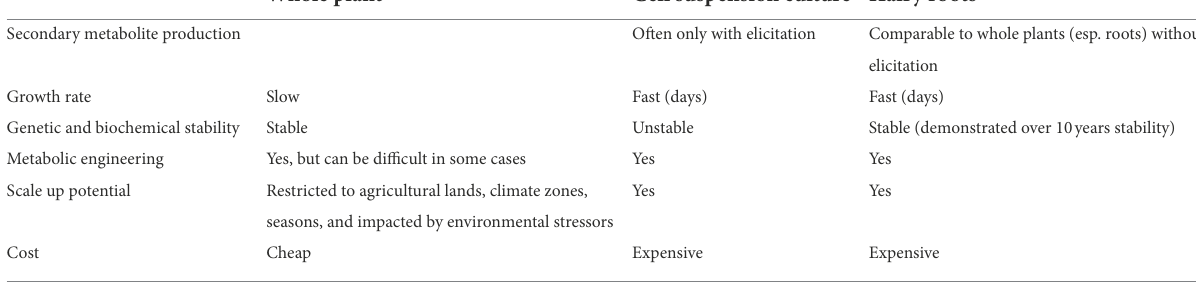
TABLE 1 Comparison of advantages and disadvantages of plant culture types. Whole